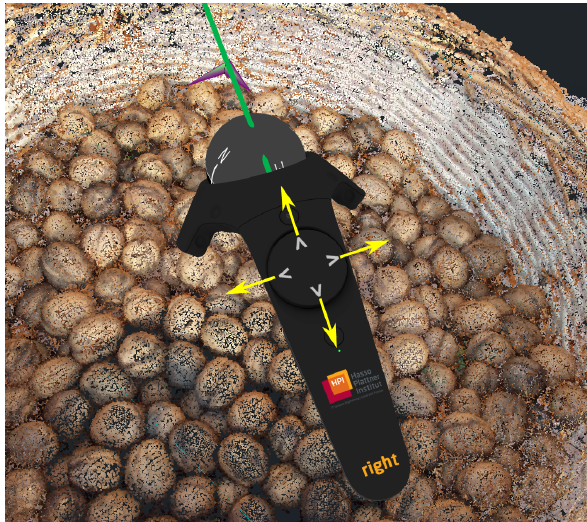
Figure 5. The touchpad allows movement in the selected direction relative to the forward direction symbolized by the green